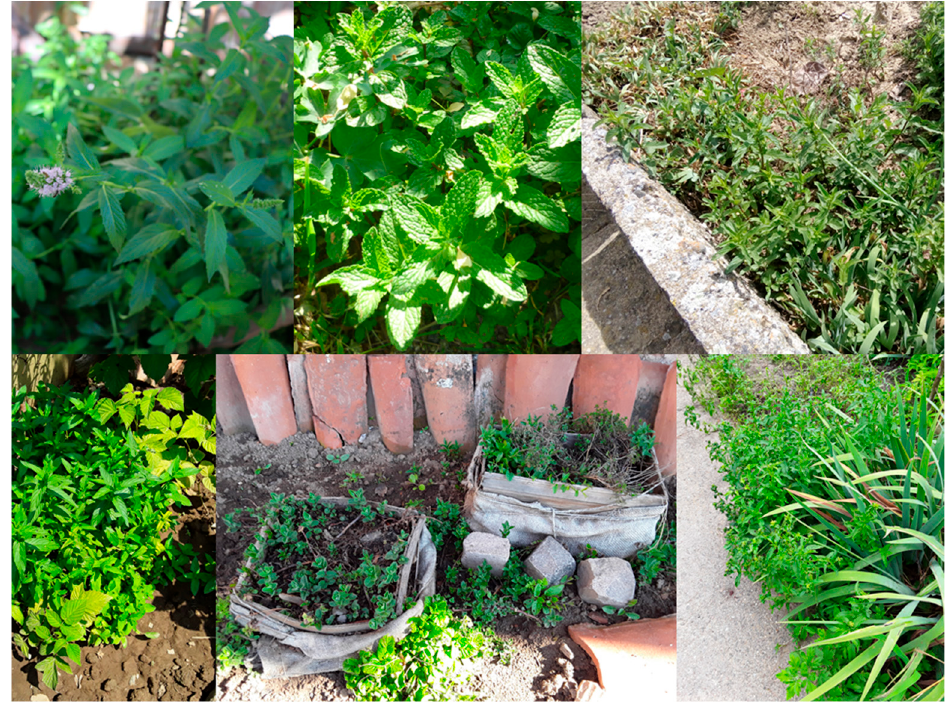
Figure 5. Variety of Mentha spicata L. local forms (landraces) in Bulgarian rural home gardens. Twenty-one taxa were used for their healing properties, with M. × piperita , M. officinalis , and Salvia officinalis being the most commonly mentioned. Still, only 30.2% of the reports were related to the healing properties of Lamiaceae taxa. For medicinal purposes, dried plants were used as infusions. Some of the participants consumed them daily as healthy herbal teas, while others associate herbal teas with childhood illnesses and reject to cultivate and/or collect medicinal plants. Taxa used for household aromatization (10 taxa), insect repellents (5 taxa), and as pollinator attraction/honey plants (2 taxa) over- lapped completely with medicinal plant category. Dried Lavandula angustifolia Mill. and Mentha spicata bunches were reported as effective in the repelling of clothes moths.